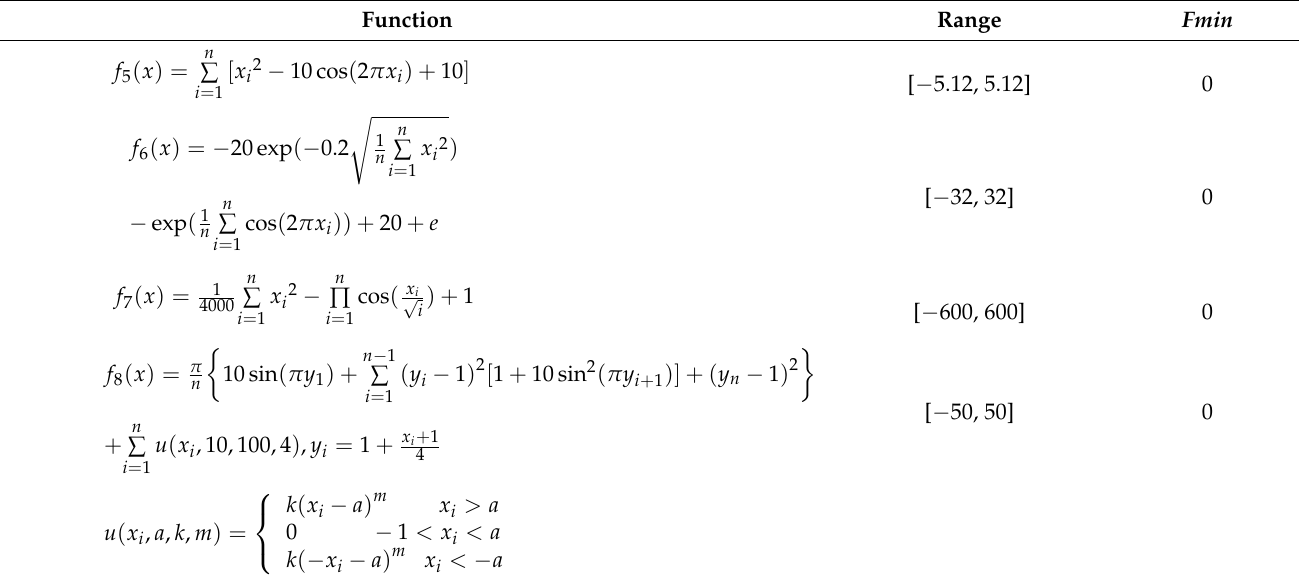
Table 2. Five high-dimensional multi-objective test functions (Dim = 30). Function Range Fmin